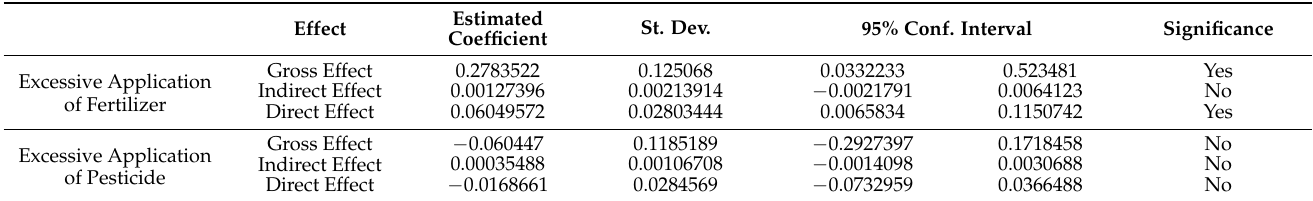
Table 8. Bootstrap test results of mediating effect.